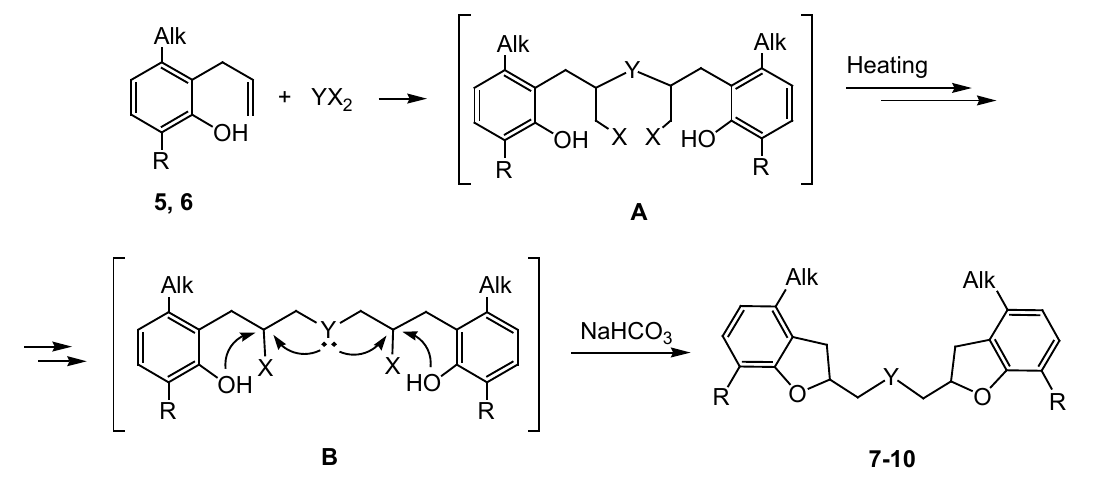
Scheme 5. A supposed pathway of the reactions of SeBr 2 , SeCl 2 and SCl 2 with allyl thymol 5 and allyl carvacrol 6 .